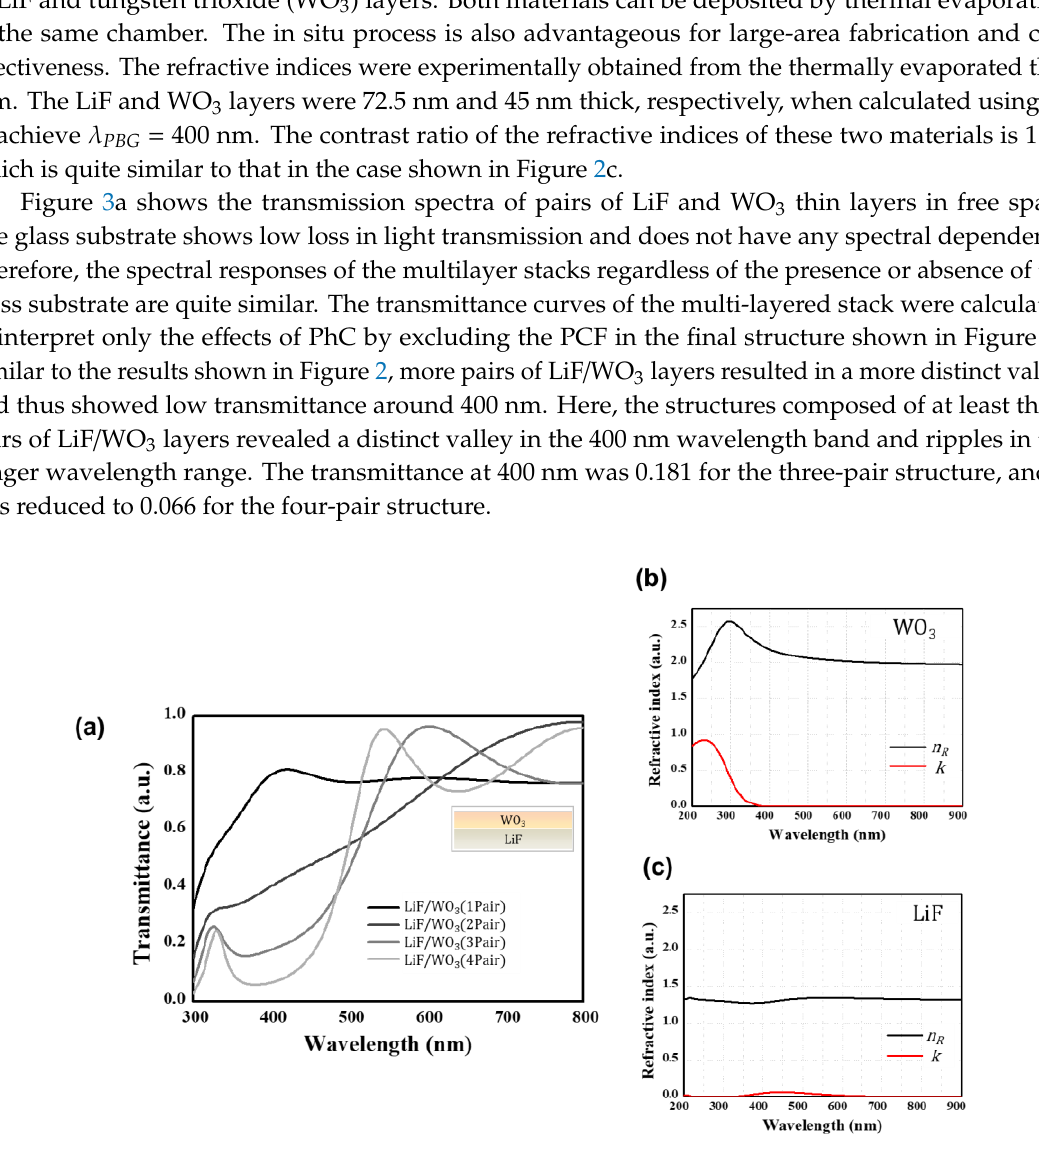
Figure 3. ( a ) Transmission spectra of multiple layers composed of Lithium fluoride (LiF) and tungsten trioxide (WO 3 ) in free space. The measured refractive indices of the thermally evaporated thin films—( b ) WO 3 and ( c ) LiF.